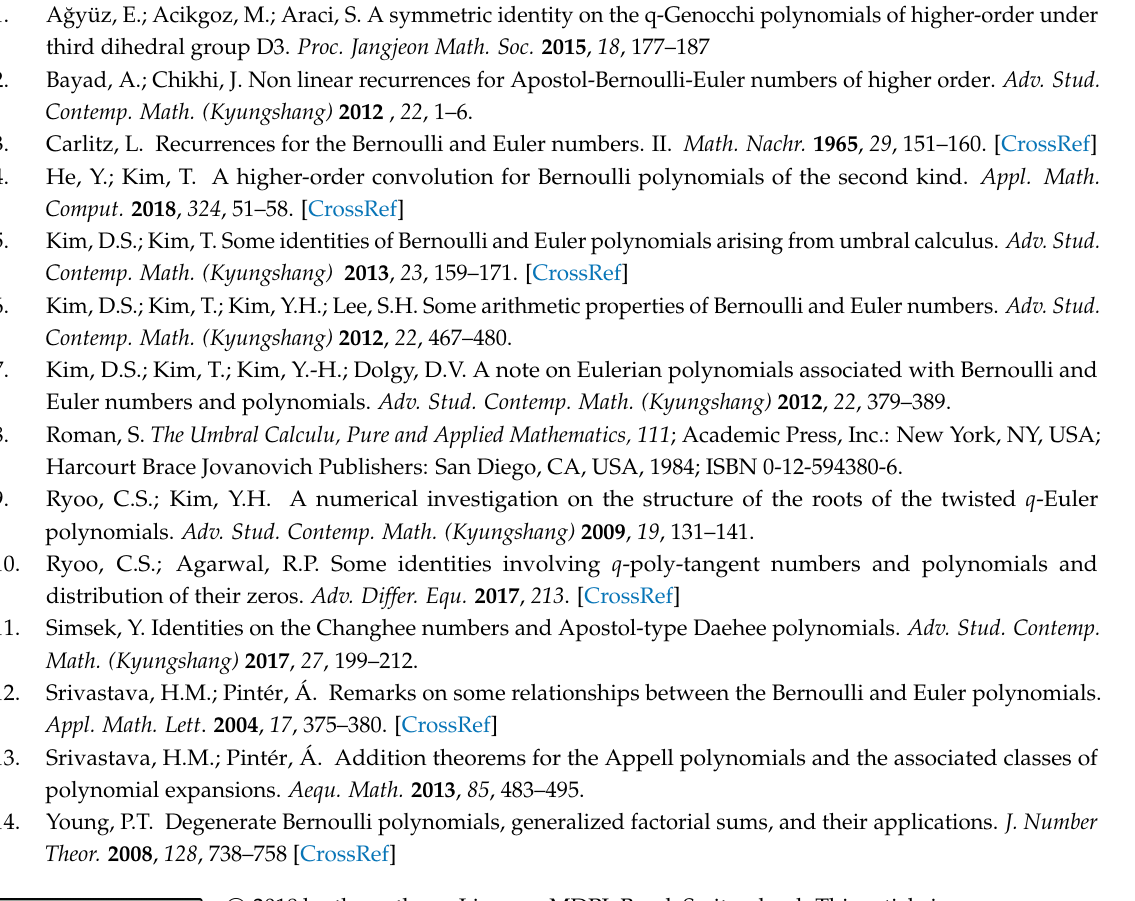
Table 4. Approximate solutionsof E